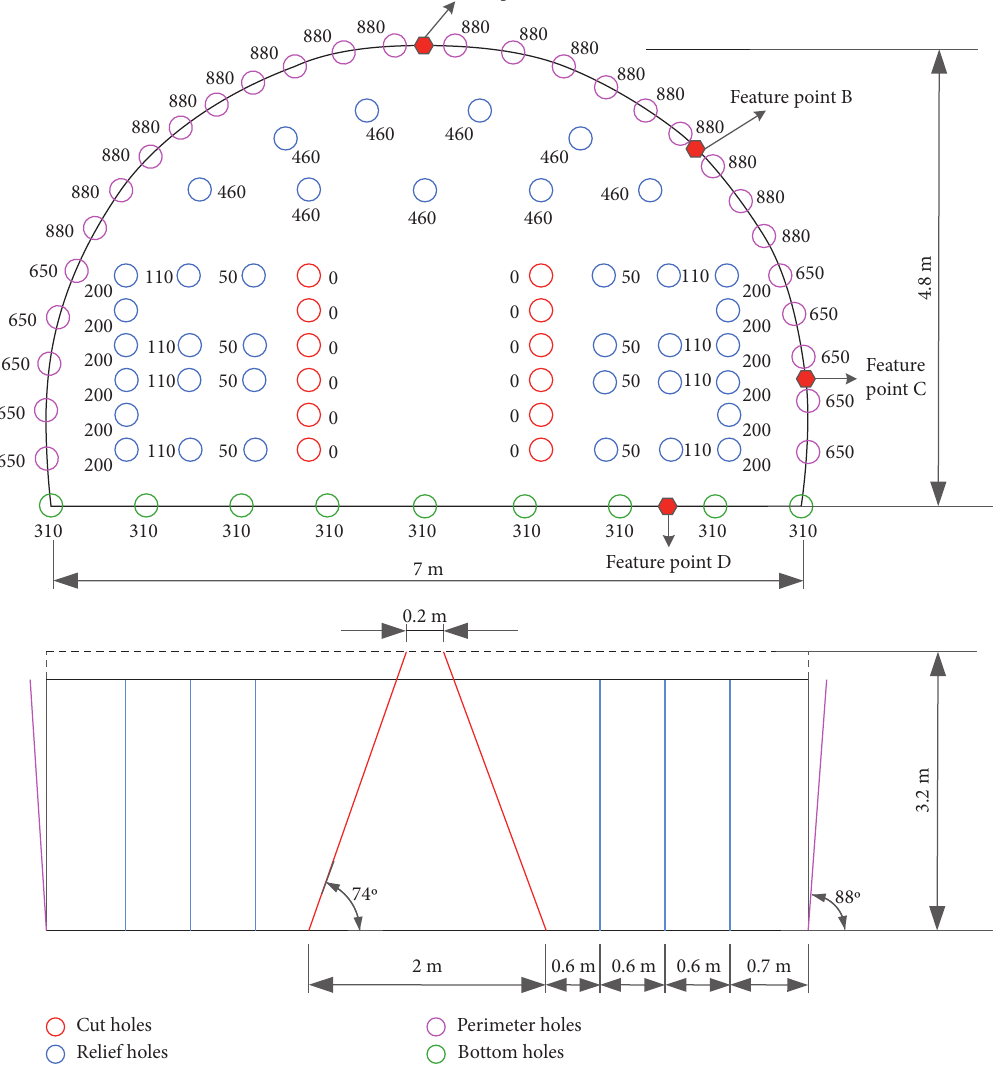
Figure 4: Schematic diagram of the arrangement of blast holes in tunnel